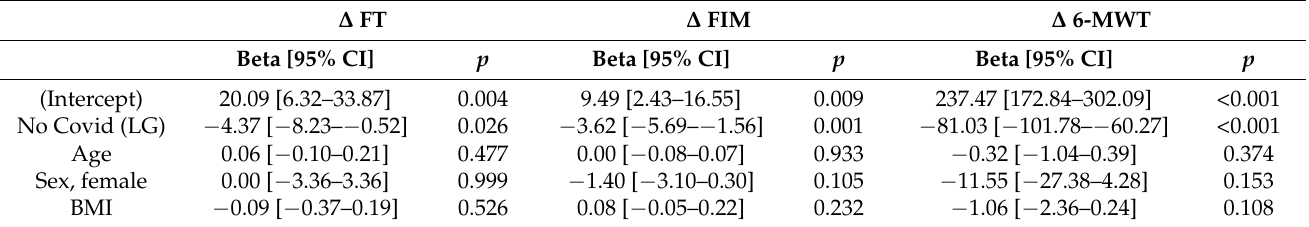
Table 7. Multivariate analysis with the ∆ of the FT, the FIM and the 6-MWT as the dependent variable. ∆ FT ∆ FIM ∆